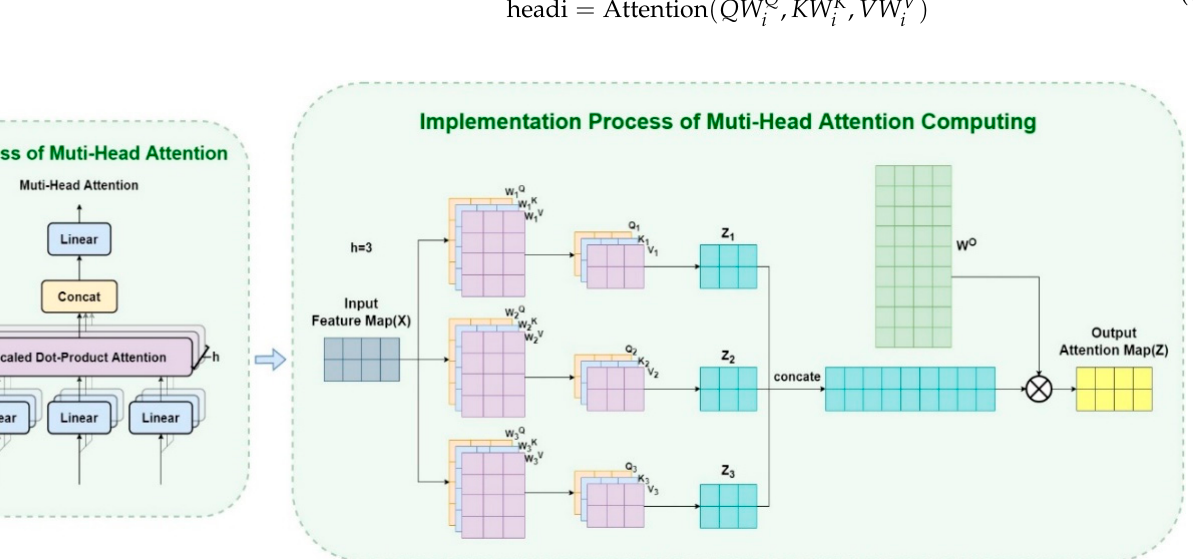
Figure 3. The implementation process of multi-head attention computing.